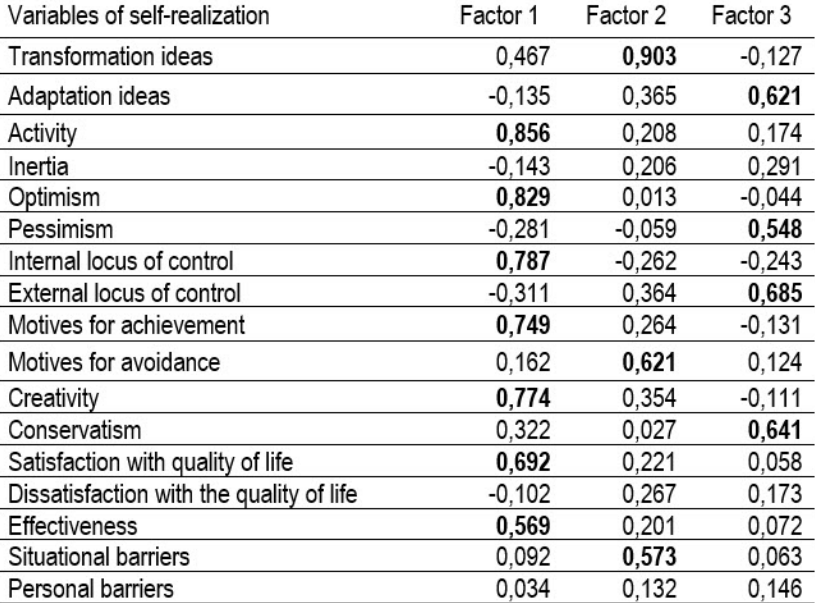
Factor structure of self-realization variables in students with a positive-stable type of self-attitude (n =